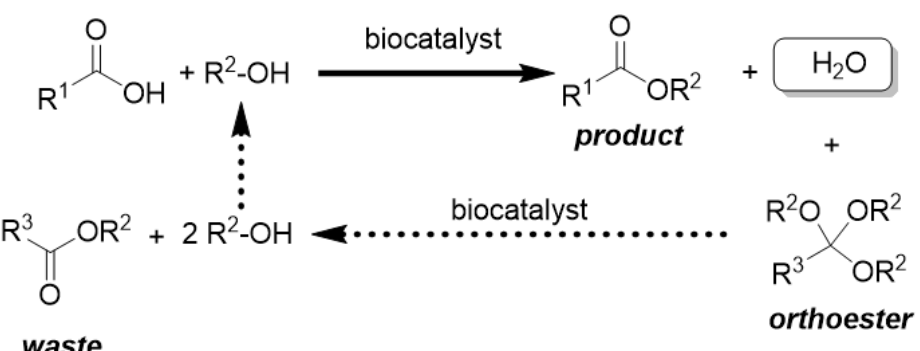
Figure 2. Schematic representation of the irreversible biocatalysed esterification of acids with orthoesters. R 1 , R 2 and R 3 may be different alkyl moieties.